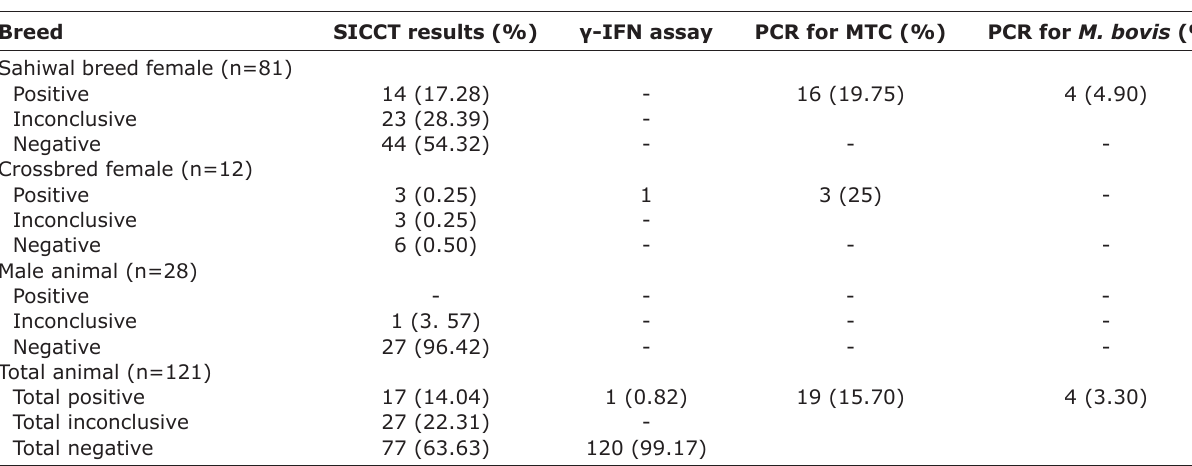
M. bovis: Mycobacterium bovis , SICCT=Single intra-dermal comparative cervical tuberculin, IFN=Interferon, PCR=Polymerase chain reaction, MTC= Mycobacterium tuberculosis complex